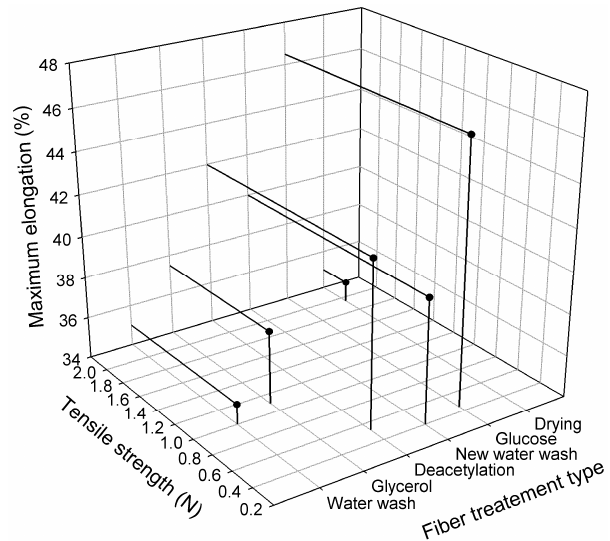
Figure 14. Mechanical properties of fiber after different production steps.